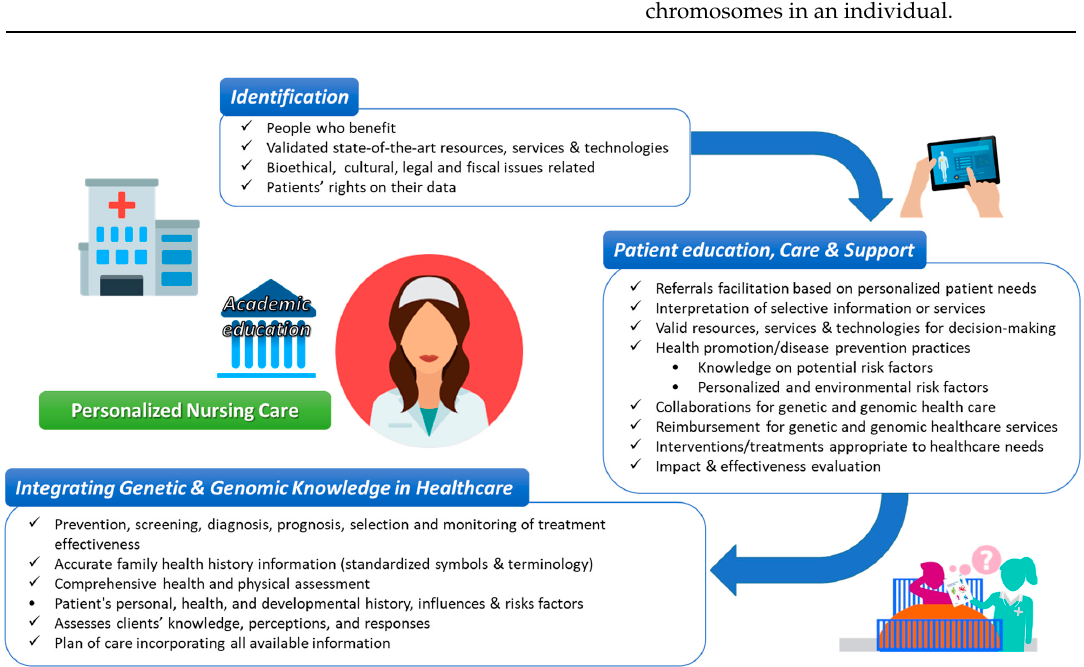
Figure 3. Personalized nursing care (PNC) in the context of PM that utilizes genomic competencies from NP.